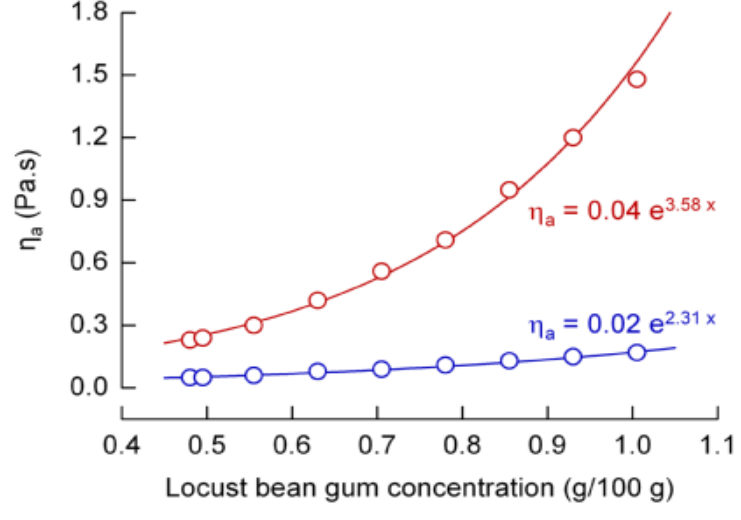
Figure 2. Apparent viscosity η as a function of locust bean gum concentration (data and a respective fits) in emulsions with 1 g/100 g fat. Shear rate is 50/s (red) and 1000/s (blue).